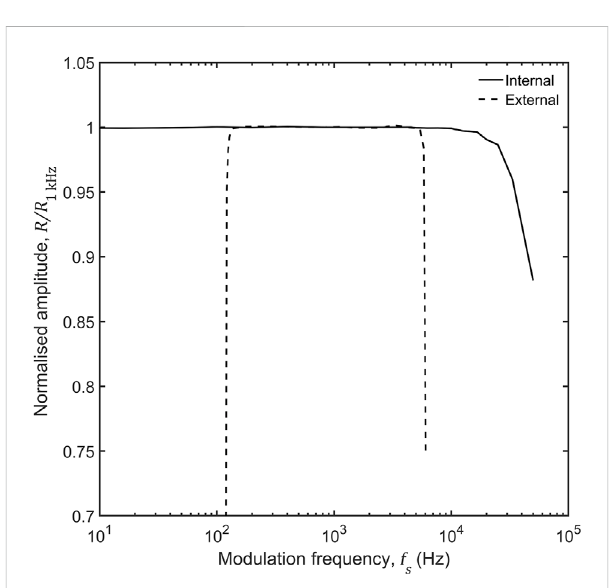
FIGURE 8 Normalised measured amplitude vs. modulation frequency for input signals of fi xed amplitude ~200 mV and zero phase; data were obtained using a time constant of 0.6 s, an input gain of 1, and referencefrequenciesmatchedtothefrequencyoftheincoming signal. The measured amplitude has been normalised to the value recorded at 1 kHz. The solid and dotted lines denote data acquired using internal and external referencing,